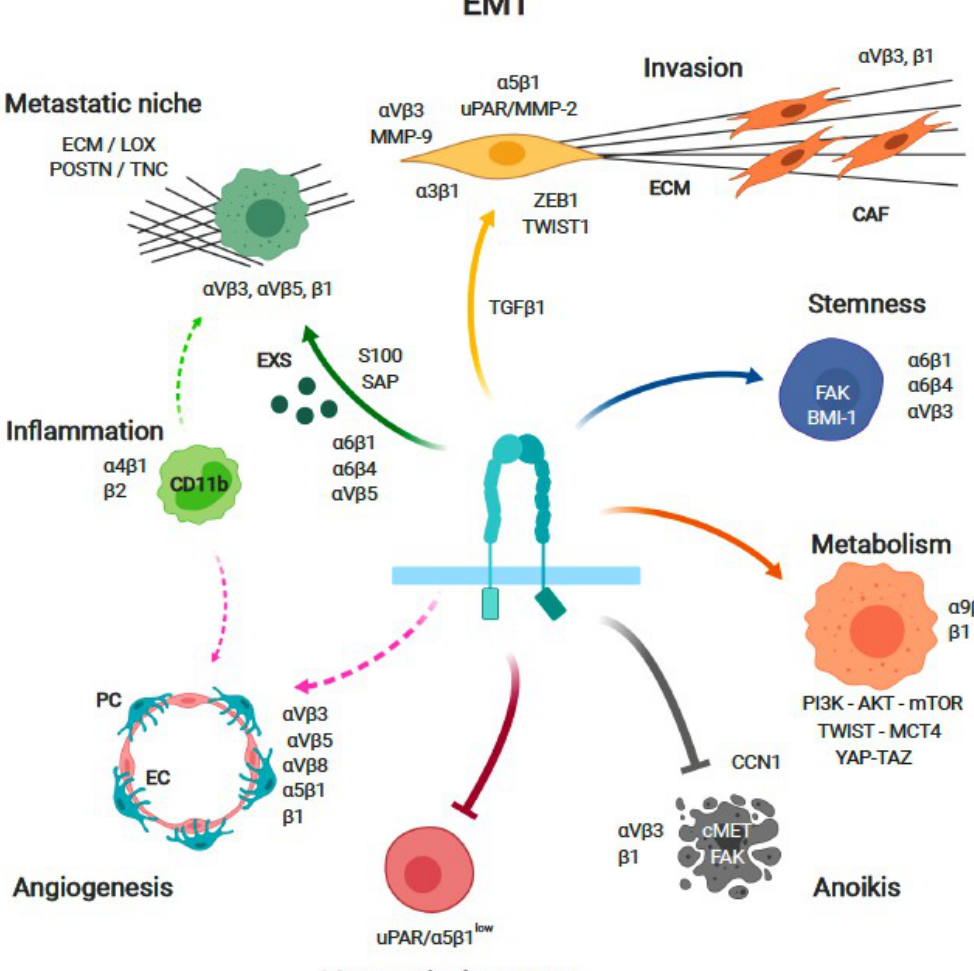
Figure 1. Integrin-dependent functions relevant to cancer. Integrins have been implicated in mediating several hallmarks of cancer, including cancer cell proliferation, dormancy, survival, stemness, metabolic adaptation, and metastatic niche formation. Integrins also promote epithelial-to- mesenchymal transition and invasion, which are two key steps of metastasis formation. In the tumor